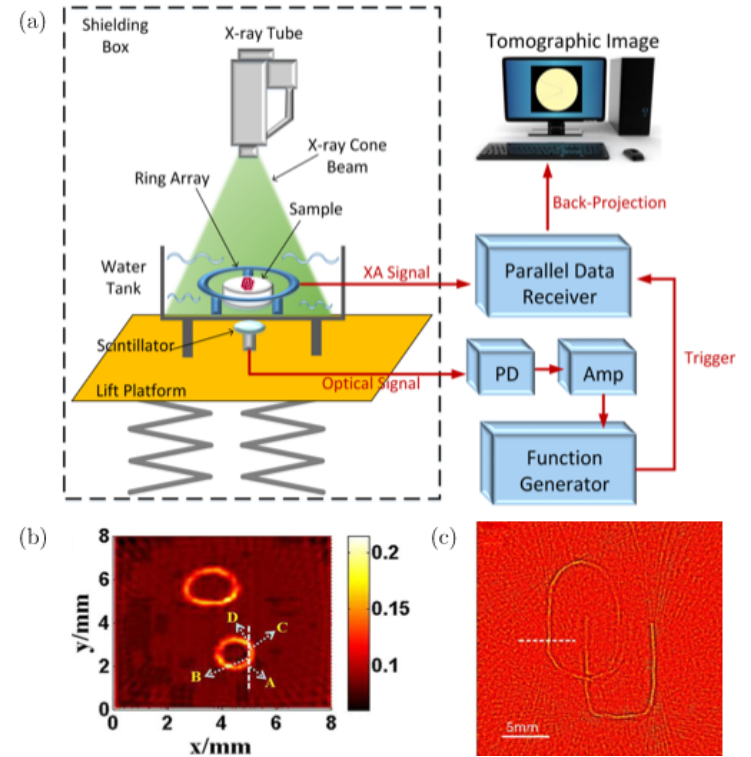
Fig. 2. (a) Schematic diagram of XACT imaging system. A scintillator/photodiode combination is activated by the X-rays and is used to tell the data receiver when to start collecting signals from the ultrasound transducer array (Fig. 1 of Ref. 13). (b) Gold ¯ducial marker XACT image (Fig. 3 of Ref. 12). (c) Lead OU logo XACT image (Fig. 3 of Ref.